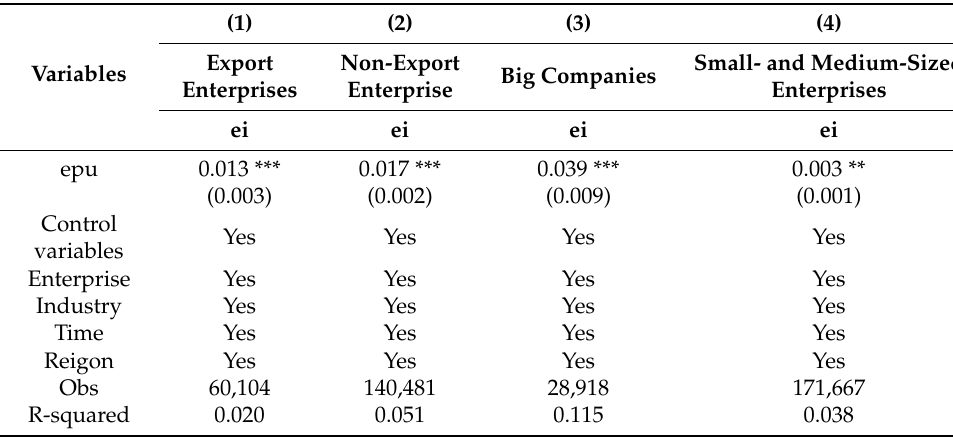
Table 3. Results of enterprise export status and size